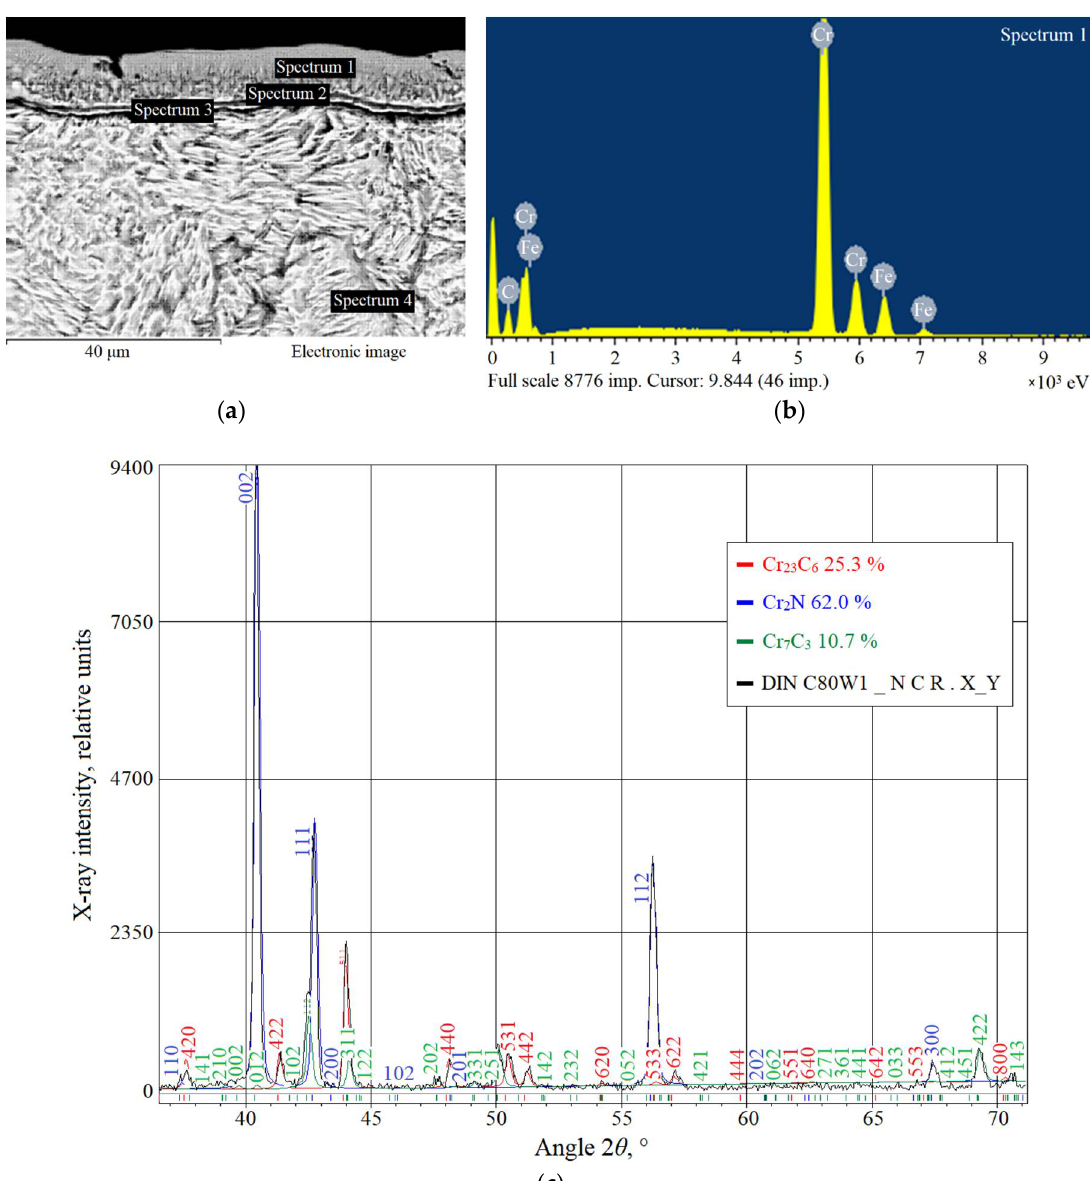
Figure 4. Microstructure in reflected electrons ( a ), diffractogram ( b ), and spectral curves ( c ) of steel DIN C80W1 after chroming and nitrogenchroming (temperature—1050 °C, time—4 h).